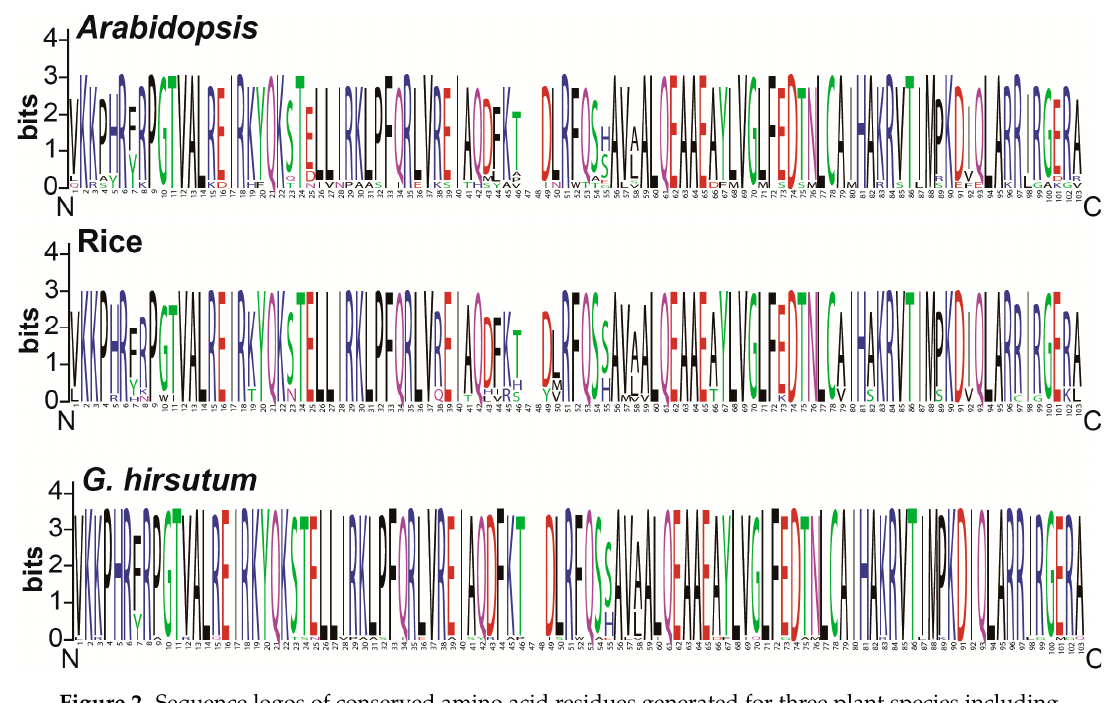
Figure 2. Sequence logos of conserved amino acid residues generated for three plant species including Arabidopsis (first), rice (second), and Gossypium hirsutum (third) exhibited highly conserved sequence logos during the evolution of dicots and monocots plant species.